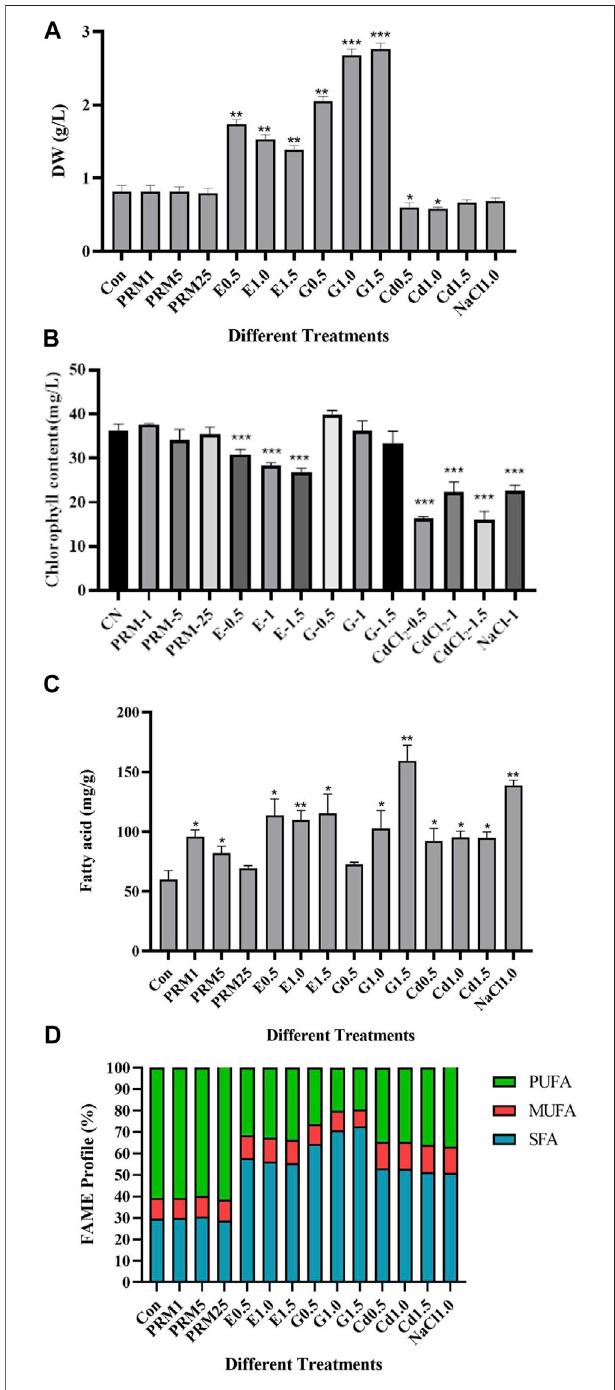
FIGURE 1 | Physiological changes of E. gracilis under different treatments. Dried weights (A) , chlorophyll contents (B) , variations of fatty acids contents (C) and FAME pro fi le (D) of E. gracilis under different treatments. Asterisks “ * ” , “ ** ” indicate signi fi cant differences between treatments and control treatment (Con) at p < 0.05 and p < 0.01, respectively. Treatments include supplementation with paromomycin (PRM1, 5, 25 as1, 5, 25 μ g/ml), ethanol (E0.5, 1.0, 1.5 as 0.5, 1, 1.5% vol/vol), glucose (G0.5, G1.0,G1.5as0.5, 1.0, 1.5% weight), CdCl2 (Cd0.5,1.0, 1.5 asCdCl2